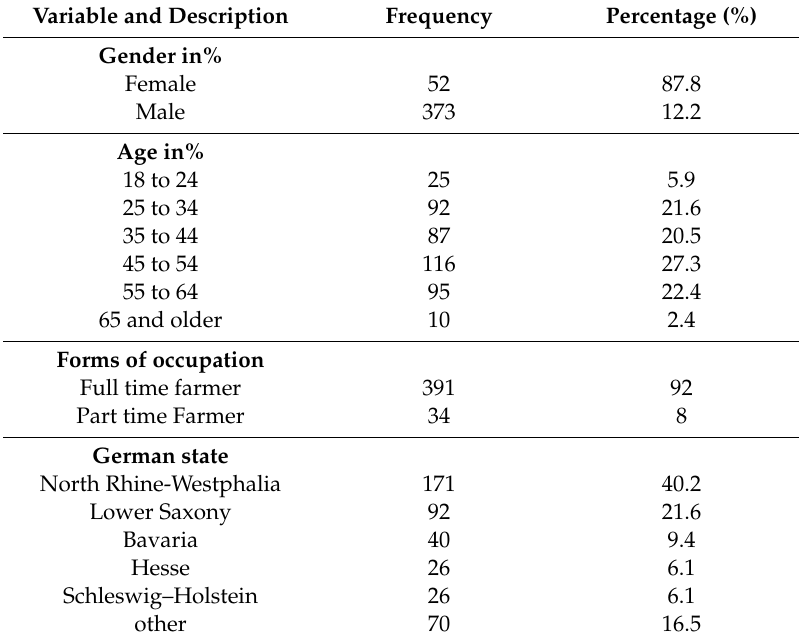
Table A1. Profiles of the respondents, n = 424.